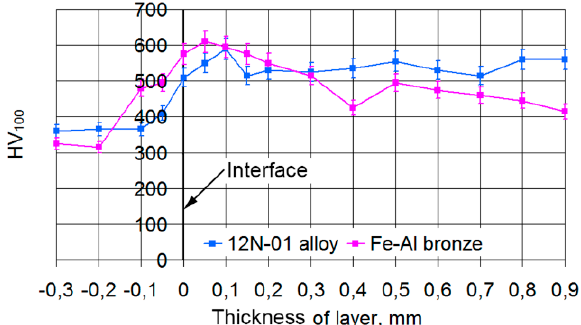
Figure 13. Microhardness distribution through the thickness of a single composite layer: the cladding speeds of alloy and bronze are, respectively, 120 and 200 mm/min; the cladding pitches of alloy and bronze are K1 = 2.4 mm and K2 = 1.2 mm, respectively.